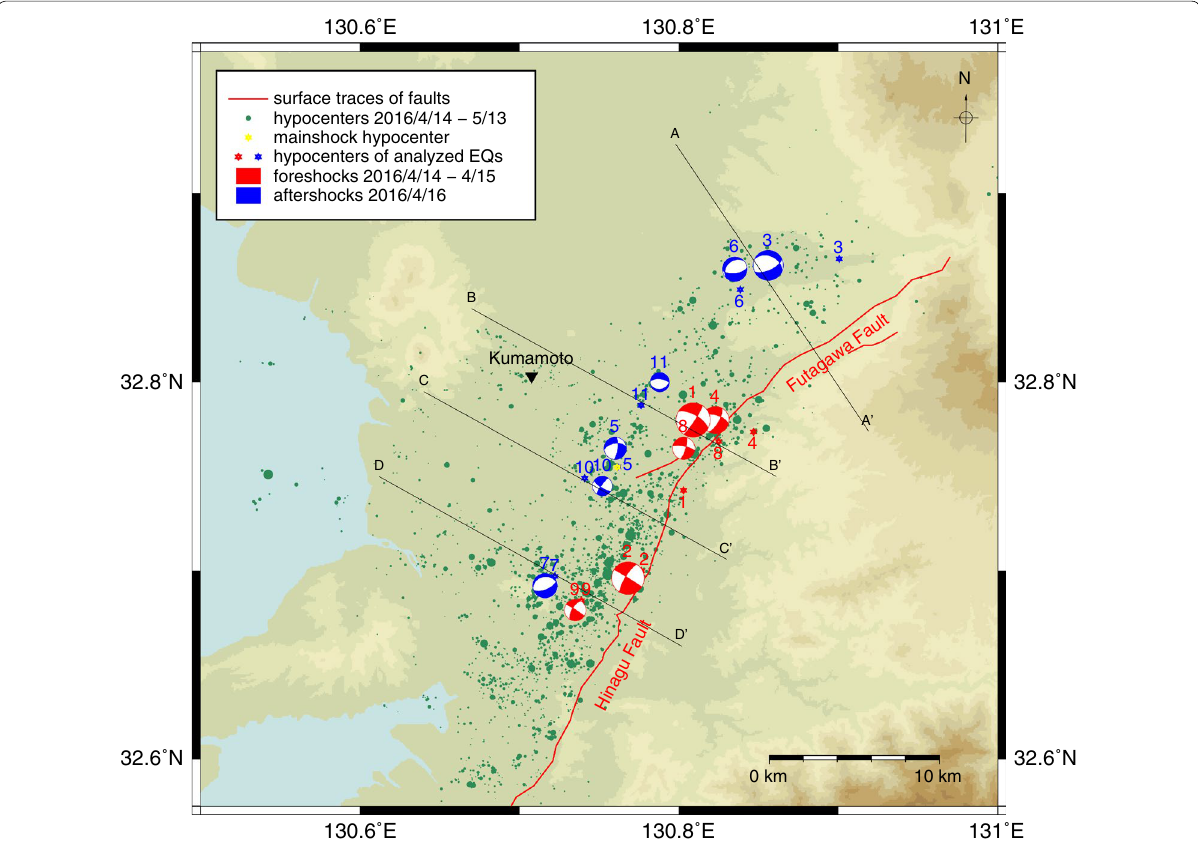
Fig. 8 Map of inferred CMTs of the Kumamoto earthquake sequence; CMTs are shown by beach-ball representation of the best DC source. The background seismicity is adopted from Kato et al. (2016). The sizes of the circles are proportional to the JMA magnitude of the events. Events are numbered according to Table 2. Black lines are traces of vertical cross sections shown in Fig. 9. For details, see